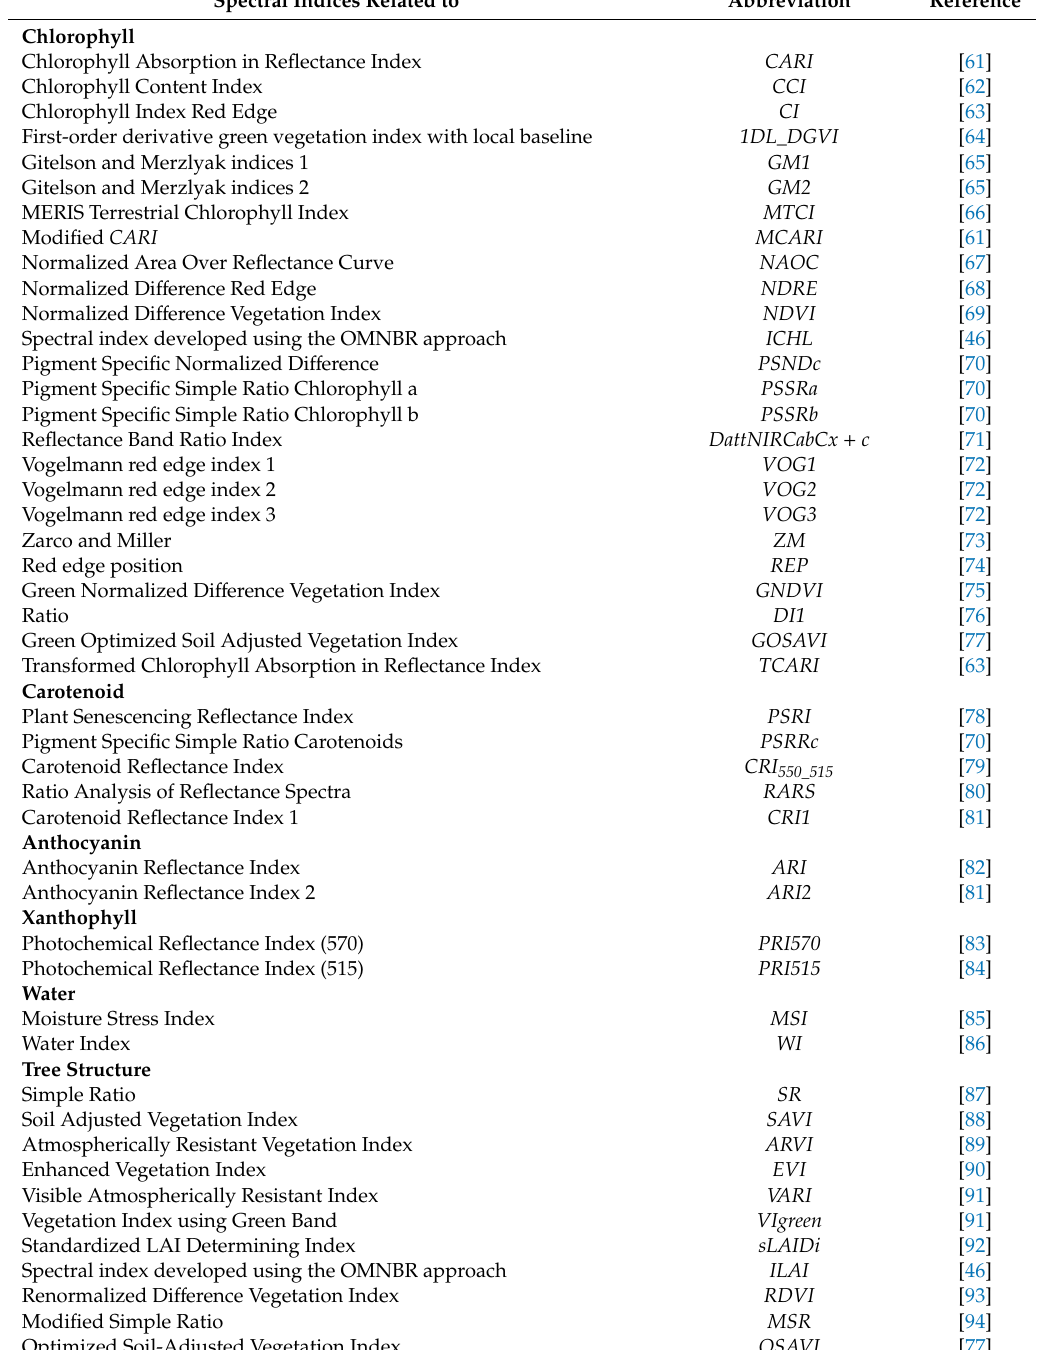
Table 3. Indices calculated from airborne hyperspectral